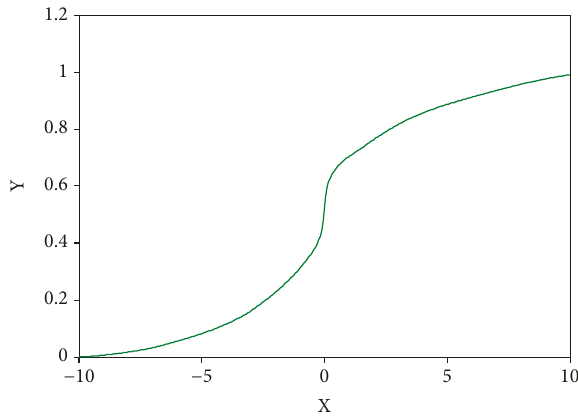
Figure 3: Graphics of logistic